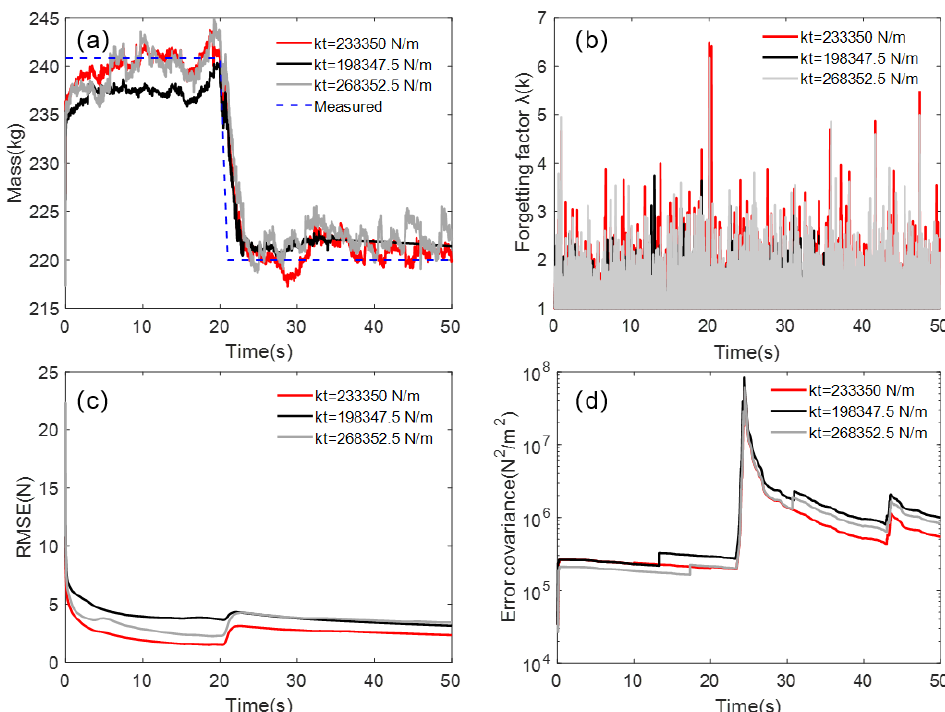
Figure 14. Experimental result of vehicle mass estimation with respect to different tire stiffness ( a ) estimated vehicle mass according to tire stiffness, ( b ) time evolution of the forgetting factor, ( c ) RMSE, and ( d ) convergence history of error covariance. Table 4. Comparison of MRMSE for different tire